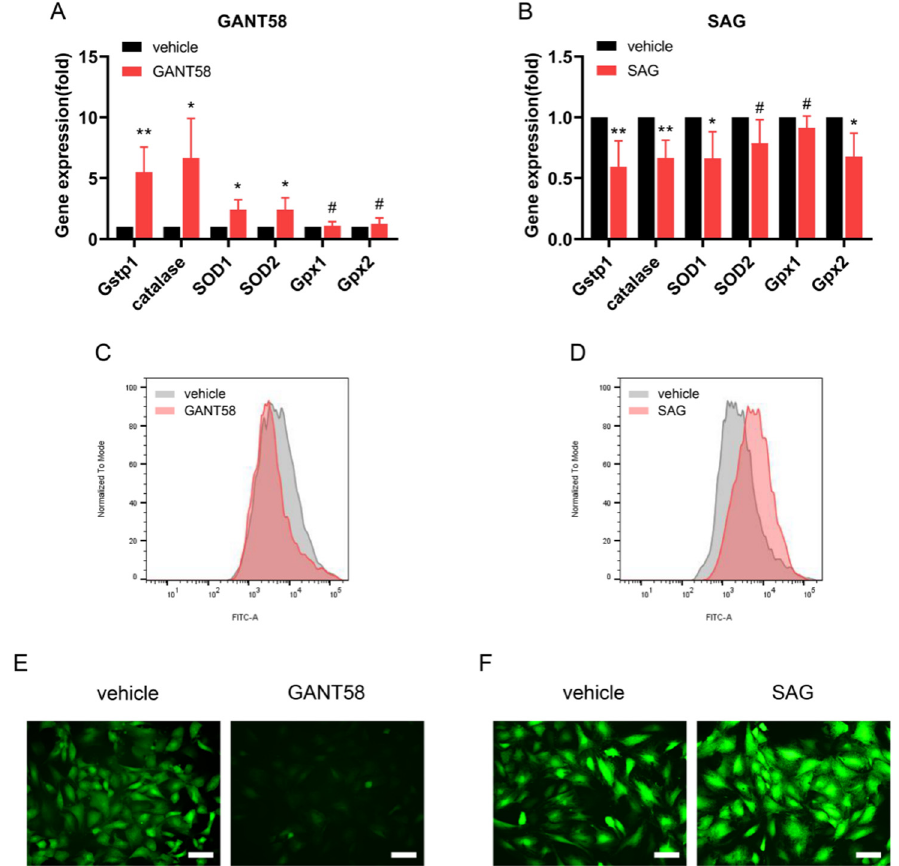
Figure 6. Hedgehog signalling regulates antioxidant pathway in osteogenic differentiation of TDSCs. ( A ) qRT–PCR analysis of antioxidant related genes in TDSCs treated with 25 mM GANT58 under weeklong osteogenic induction. ( B ) qRT–PCR analysis of antioxidant related genes in TDSCs treated with 2 mM SAG under weeklong osteogenic induction. ( C , E ) TDSCs were treated with 25 mM GANT58 under osteogenic induction for 48 h, followed by detection of reactive oxygen species (ROS) levels by flow cytometry ( C ) and fluorescent microscopy ( E ). ( D , F ) TDSCs were treated with 2 mM SAG under osteogenic induction for 48 h, followed by detection of ROS levels by flow cytometry ( D ) and fluorescent microscopy ( F ). * p < 0.05, ** p < 0.01, # no